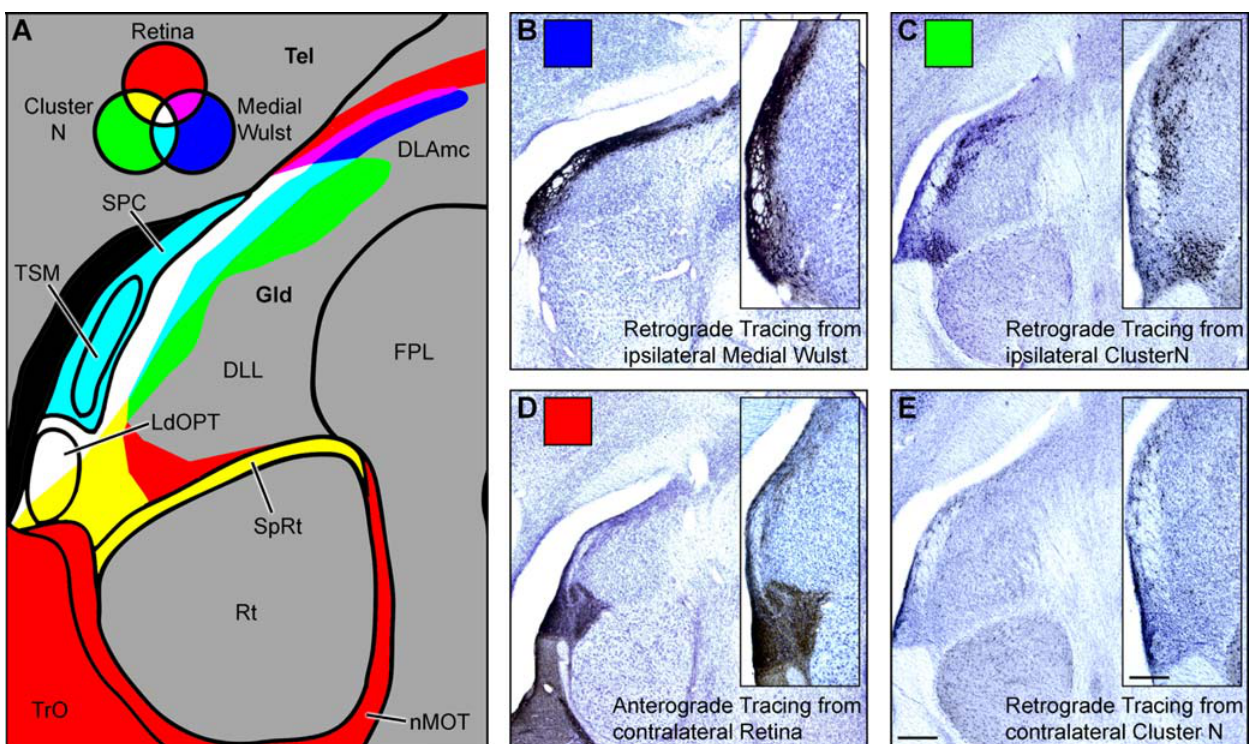
Figure 2. Cluster N is linked to a specific subsystem of the thalamofugal visual pathway. A: Schematic overview of anatomical features according to cresylviolet staining (shown in B, C and D) and tracing patterns in the thalamus. Each input source (retina, red; medial wulst, blue; Cluster N, green) and their overlapping tracing patterns are color-coded separately. Retinofugal fibers show a high degree of overlap with neurons projecting upon Cluster N (shown in yellow) in ventral parts of the DLL, the SpRt and the LdOPT, whereas neurons projecting upon the medial wulst exclusively co- localize with retinofugal fibers only in dorsal DLL regions and the DLAmc (shown in magenta). Lateral parts of the DLL, which receive afferents from the retina, project upon the medial wulst and Cluster N (shown in white). B: Retrograde tracing pattern from the medial visual wulst, ipsilateral side. Neurons are mainly located in lateral parts of the DLL and LdOPT with few single neurons positioned in lateral parts of the DLAmc. C: Retrograde tracing pattern from Cluster N, ipsilateral side. Labeled neurons cover lateral and ventral parts of the DLL and are found in the SpRT and LdOPT (compare Fig. 1C). D: Contralaterally projecting retinofugal fibers innervate the LdOPT, SpRt and lateral/ventral parts of the DLL, the nMOT and a small band along the lateral DLL reaching parts of the DLAmc (compare Fig. 1C). E: Retrograde tracing pattern from Cluster N, contralateral side. Few scattered neurons are found in DLL and LdOPT. Scale bar (for B–E): 100 m m; scale bar in insert (for insert in B–E): 50 m m. Abbreviations: AL, Ansa lenticularis; DLAmc, Nucleus dorsolateralis anterior thalami, pars magnocellularis: DLL, Nucleus dorsolateralis anterior thalami, pars lateralis; FPL, Fasciculus prosencephali lateralis; LdOPT, Nucleus lateralis dorsalis nuclei optici principalis thalami; nMOT, Nucleus marginalis tractus optici; OM, Tractus occipitomesencephalicus; Rt, Nucleus rotundus; SPC, Nervus superficialis parvocellularis; SpRt, nucleus suprarotundus; Tel, Telencephalon; TrO, Tractus opticus; TSM, Tractus septomesencephalicus.